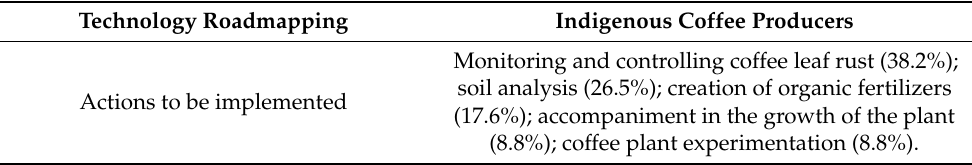
Table 5. Technology roadmapping of coffee.